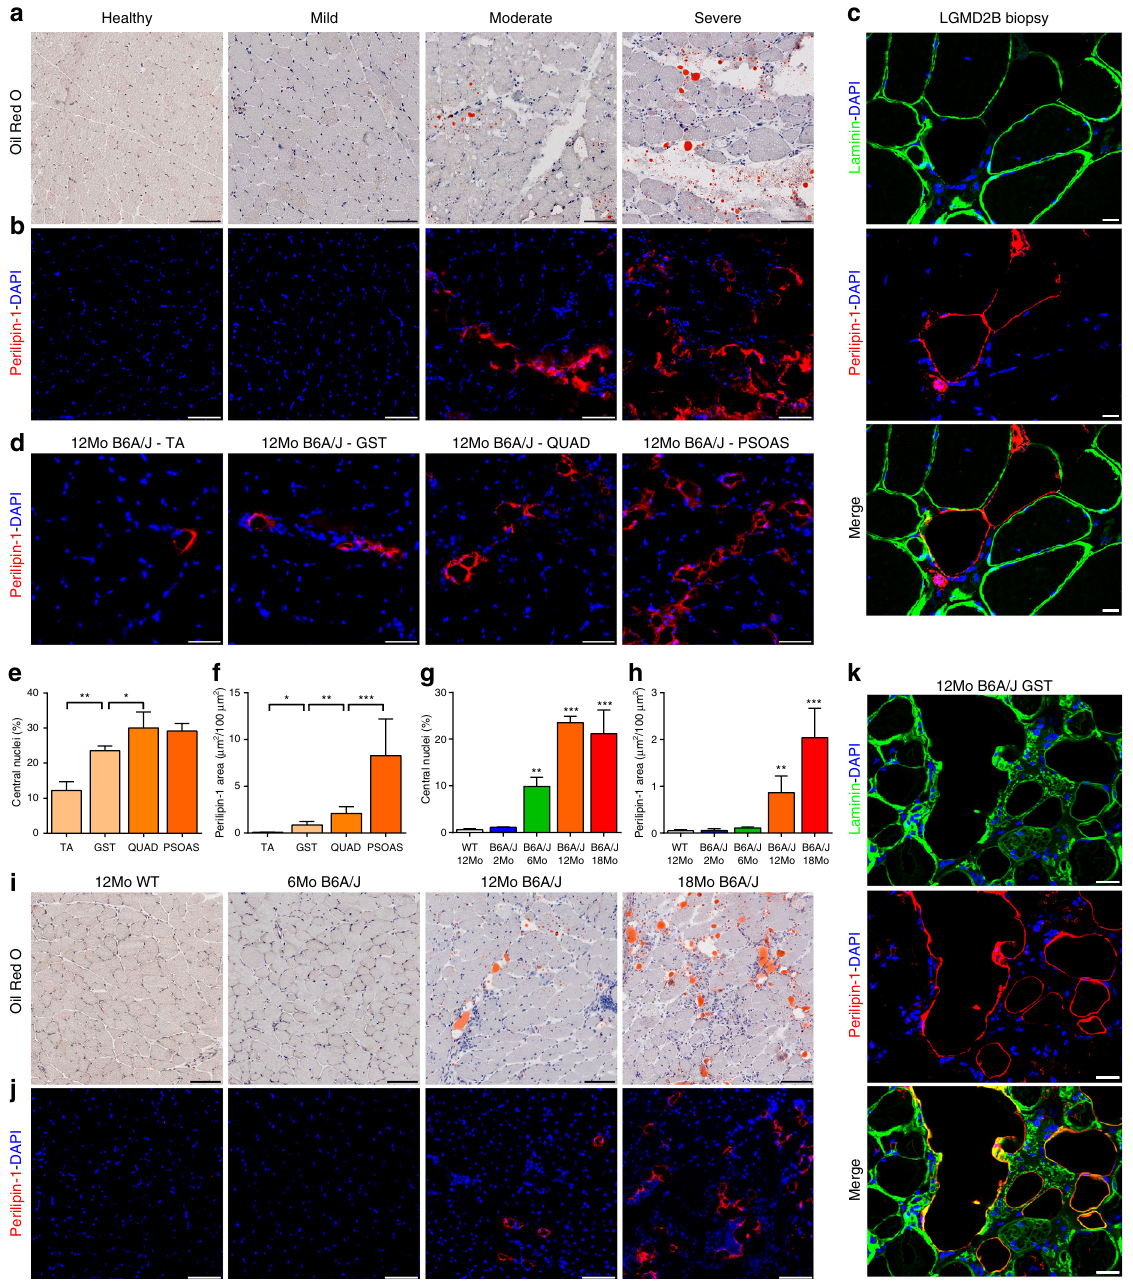
Fig. 1 Adipogenic replacement of muscle correlates with disease severity in dysferlinopathic patients and mice. Mild, moderate, and severely dystrophic LGMD2B patient and non-dystrophic control muscle cross-section stained with a Oil Red O or for b Perilipin-1 protein. c Confocal images of LGMD2B patient muscle sections showing that perilipin-1 marked lipid deposits (red) accumulate outside the boundaries of laminin-marked myo fi ber borders (green). Scale bar = 20 µ m. d 12Mo B6A/J TA, gastrocnemius, quadriceps, and psoas muscles stained for perilipin-1. Scale Bar = 100 µ m. Quanti fi cation (mean ± SD) of e myo fi ber central nucleation and f perilipin-1 area across 12Mo B6A/J muscles. Statistical comparisons performed via t -test between adjacent groups, n = 4 muscles/group. Quanti fi cation (mean ± SD) of g myo fi ber central nucleation and h perilipin-1 area from B6A/J gastrocnemius with advancing age/pathology, n = 4 mice/group. Statistical comparisons performed via ANOVA with Holm – Sidak multiple comparisons test for all means with that of 12Mo WT, * p < 0.05 ** p < 0.01, *** p < 0.001. i Oil Red O and j Perilipin-1 labeling of gastrocnemius from 6, 12, and 18Mo B6A/J and 12Mo WT. Scale bar = 100 µ m. k Confocal image of gastrocnemius muscle sections showing that perilipin-1 marked lipid deposits (red) localize outside the boundaries of laminin-marked myo fi ber borders (green) in 12Mo B6A/J. Scale bar = 20 µ